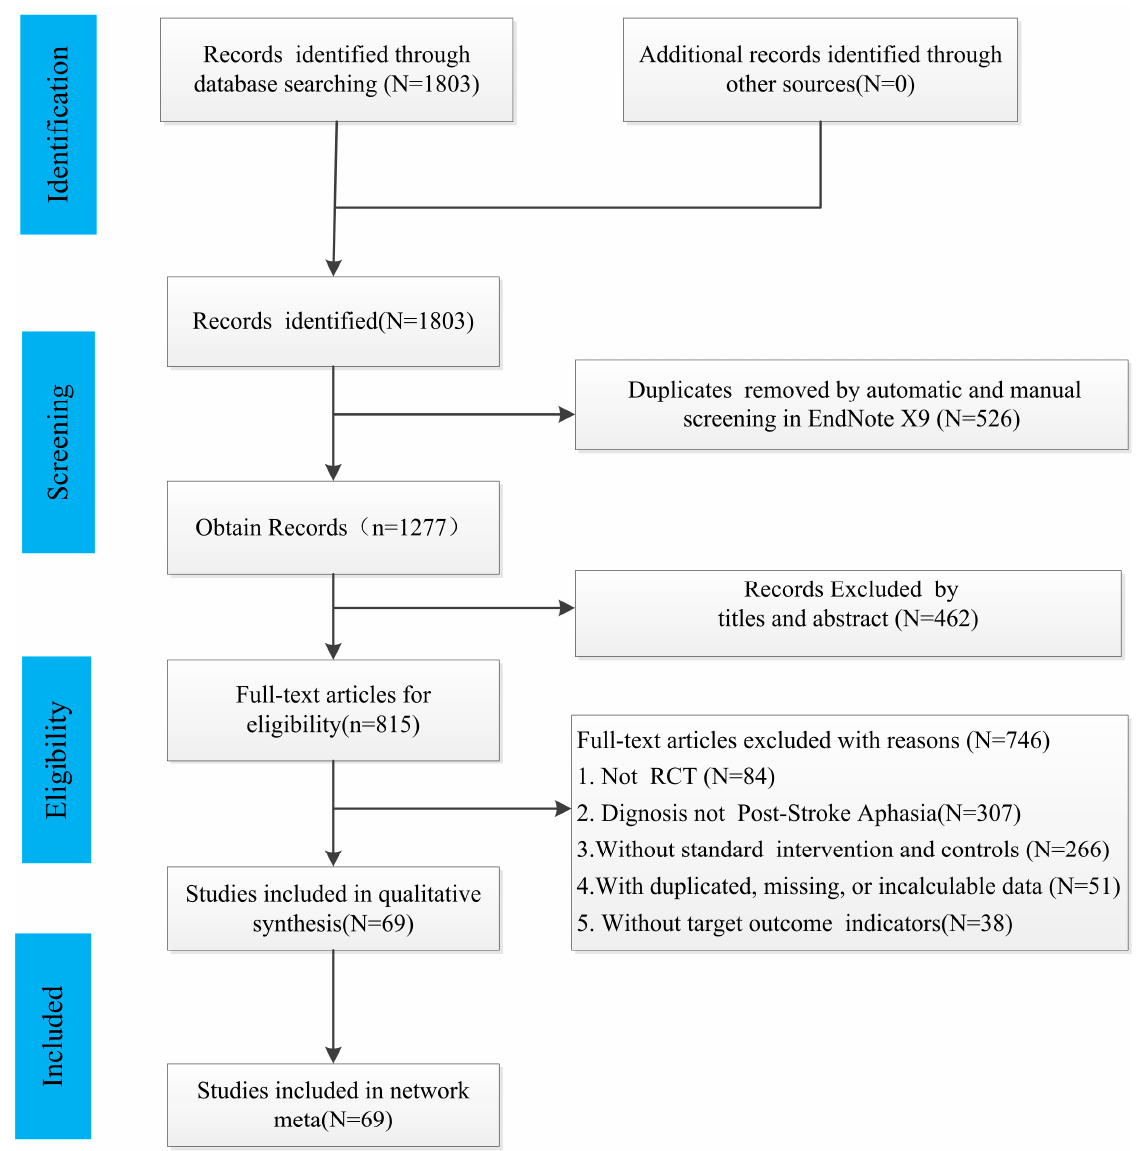
Figure 1. A PRISMA flow chart of literature research identification and selection process.